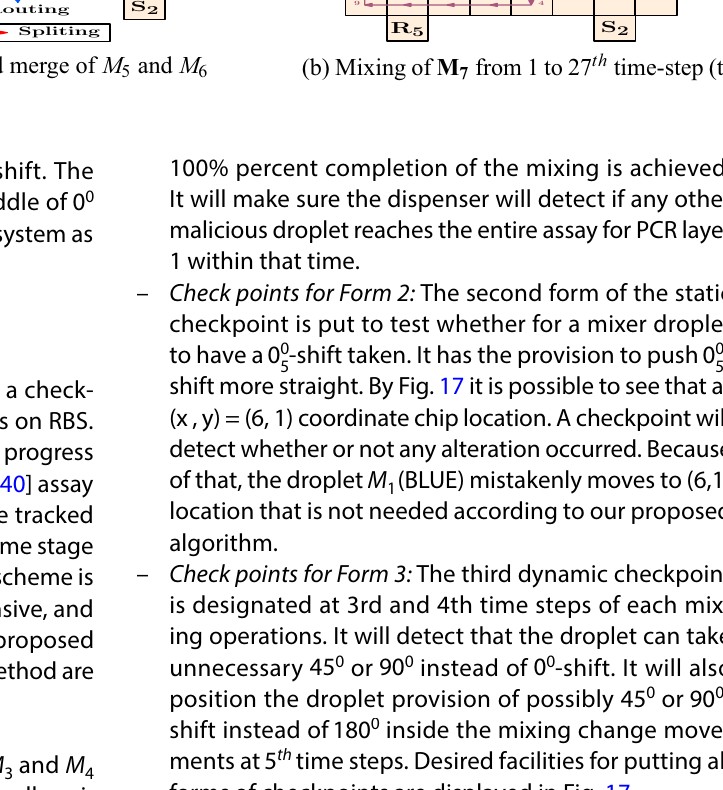
Fig. 16 a PCR layer 2 comple- tion and corresponding split_ merge steps, b RBS mixing paths for M 7 . *t = 0.0625 sec by considering working frequency be 16Hz